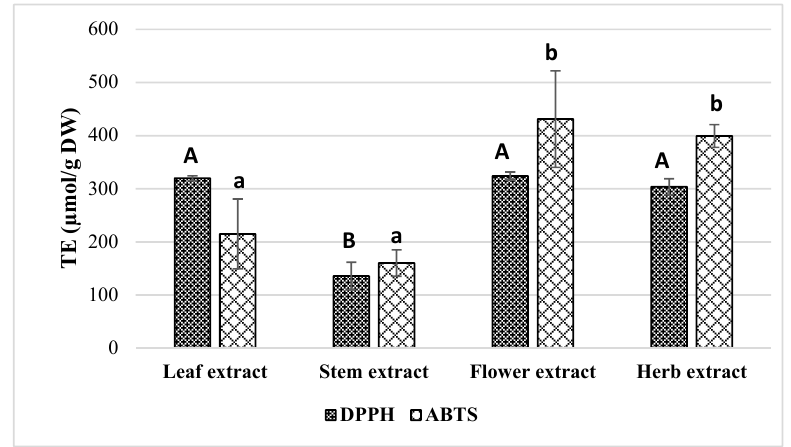
Figure 2. Antiradical (DPPH and ABTS radical scavenging) activities of ethanolic E. ciliata extracts. Results are means ± SD. Values with di ff erent capital (DPPH) and lowercase (ABTS) letter(s) are significantly di ff erent ( p < 0.05) measured by Tukey‘s